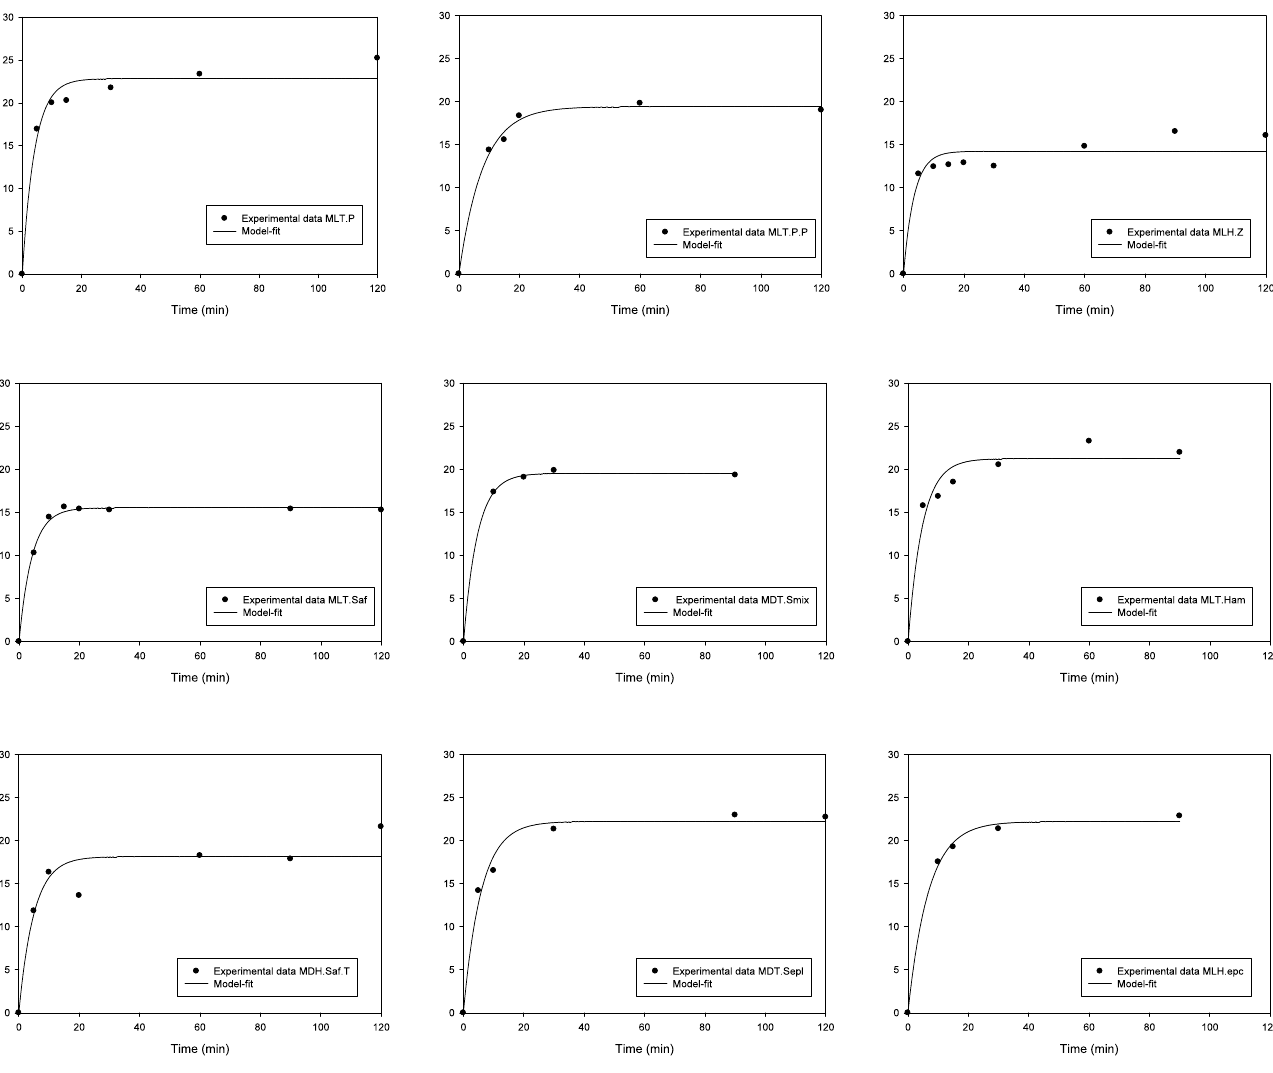
data. Overall, computed digestibility curves provided a very good fit to all experimental data, with R 2 > 0.9 and standard Error of estimate (SEE) < 6% for most landraces. Predicted values (C ∞ , and k) were obtained from the first-model